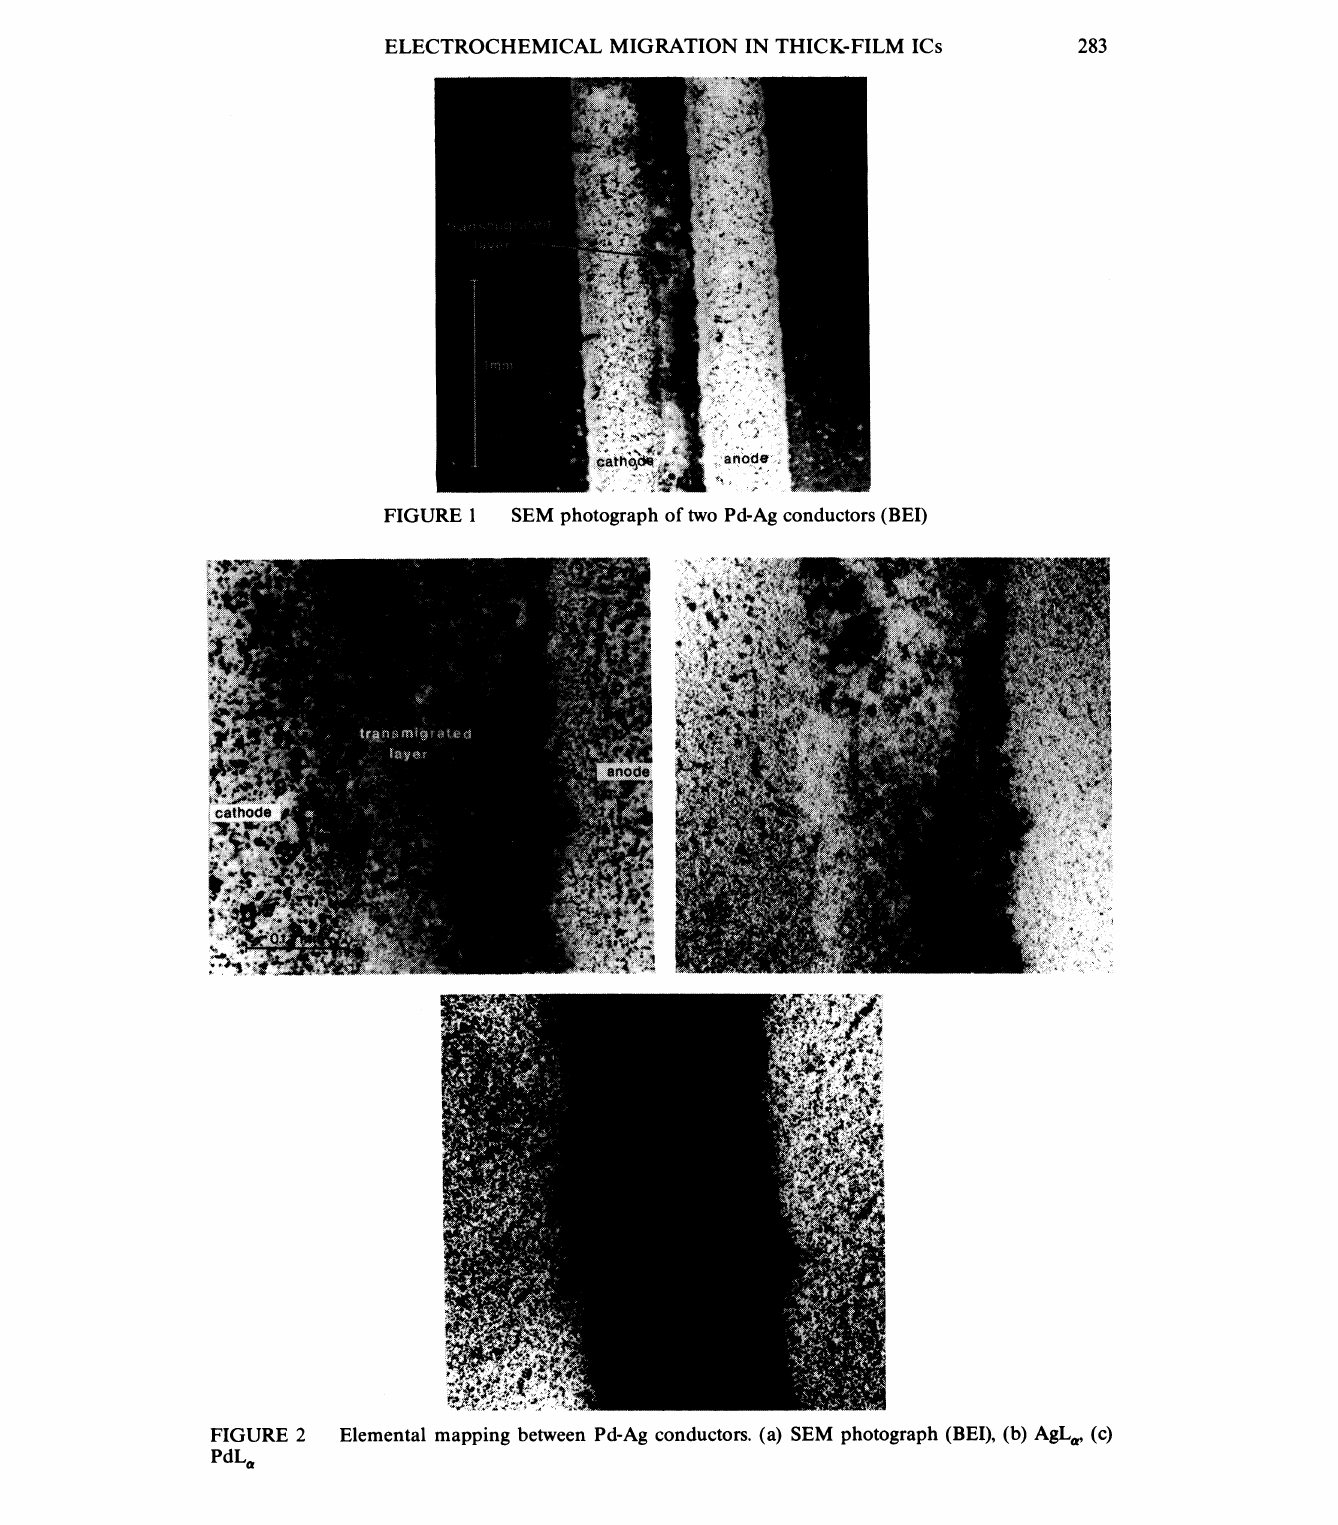
FIGURE 2 Elemental mapping between Pd-Ag conductors. (a) SEM photograph (BEI), (b) AgL (c)